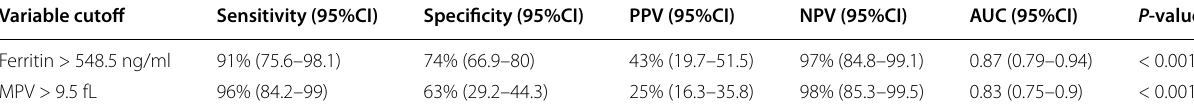
Table 7 Validity of ferritin and MPV in predicting COVID-19 severity